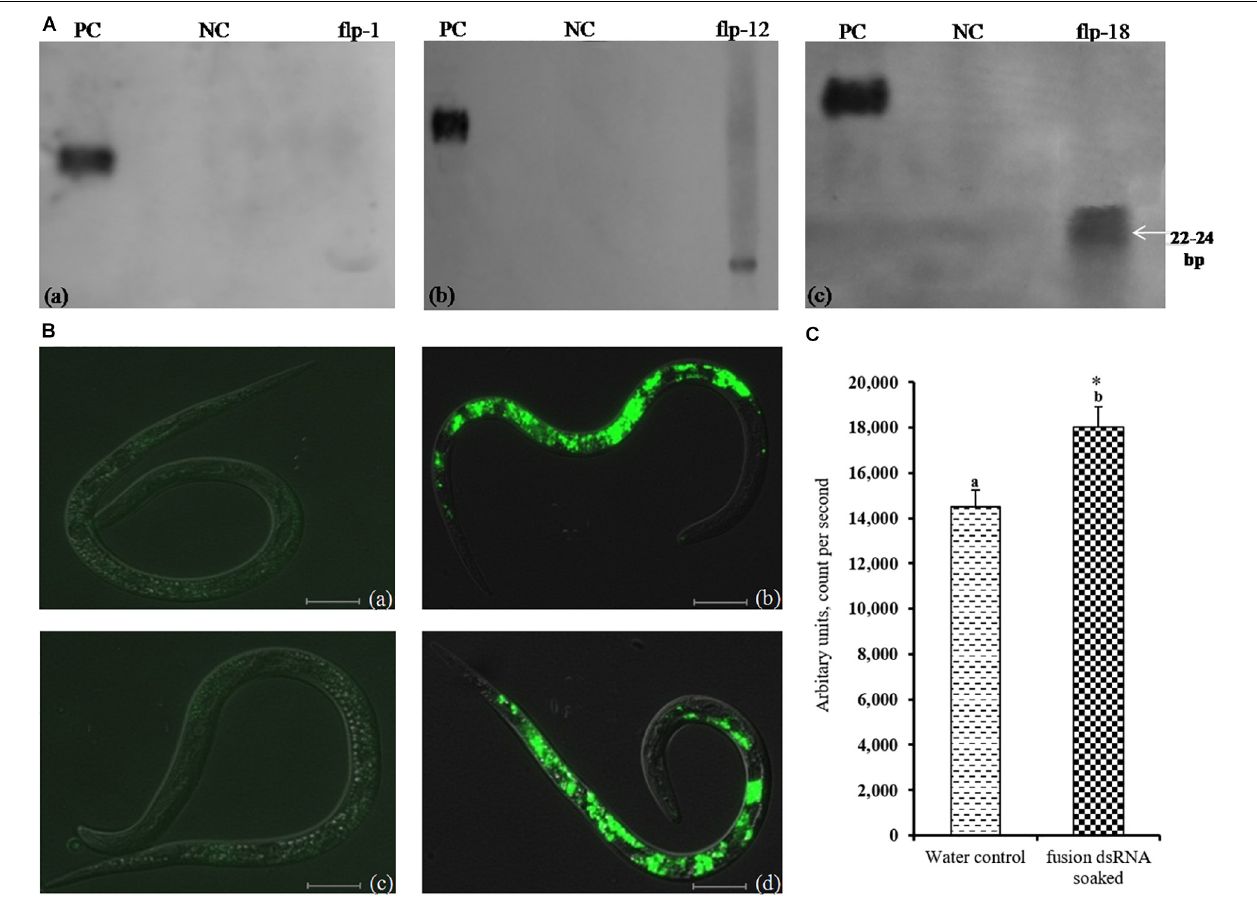
FIGURE 4 | (A) Northern blot analysis for detection of siRNA in M. incognita J2s incubated in FLPs-fusion dsRNA. (a) Mi-flp1 , (b) Mi-flp12 , (c) Mi-flp18 . PC – positive control (gene specific labeled probe: 25 pg); NC – negative control (total RNA from control healthy worms), (B) dsRNA uptake confirmation of M. incognita J2s incubated in FLPs-fusion dsRNA labeled with Alexa Flore 488 dUTPs using florescent microscope, (a,c) J2s without dsRNA, (b,d) dsRNA ingested J2s, fluorescence was localized in the stylet, esophageal gland cells, and intestine. Scale bar = 10 and 20 µ m. (C) Difference in the fluorescence count between the water control and FLPs-fusion dsRNA soaked worms. Maximum fluorescence was quantified in 5000 flashes per minute using EnSpire R (cid:13) Multimode Plate Reader ( t = 2.306, p > 0000001). a , b , ∗ Represents the values are statistical significant ( t = 2 . 306, p >